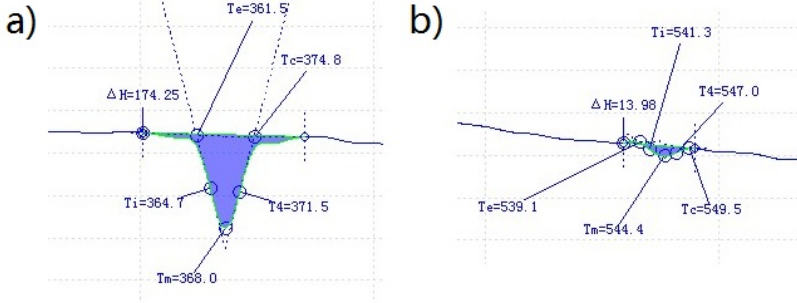
Figure 6. Two inflection points of the differential thermal analysis (DTA) curve, ( a ) the first point and ( b ) the second point.